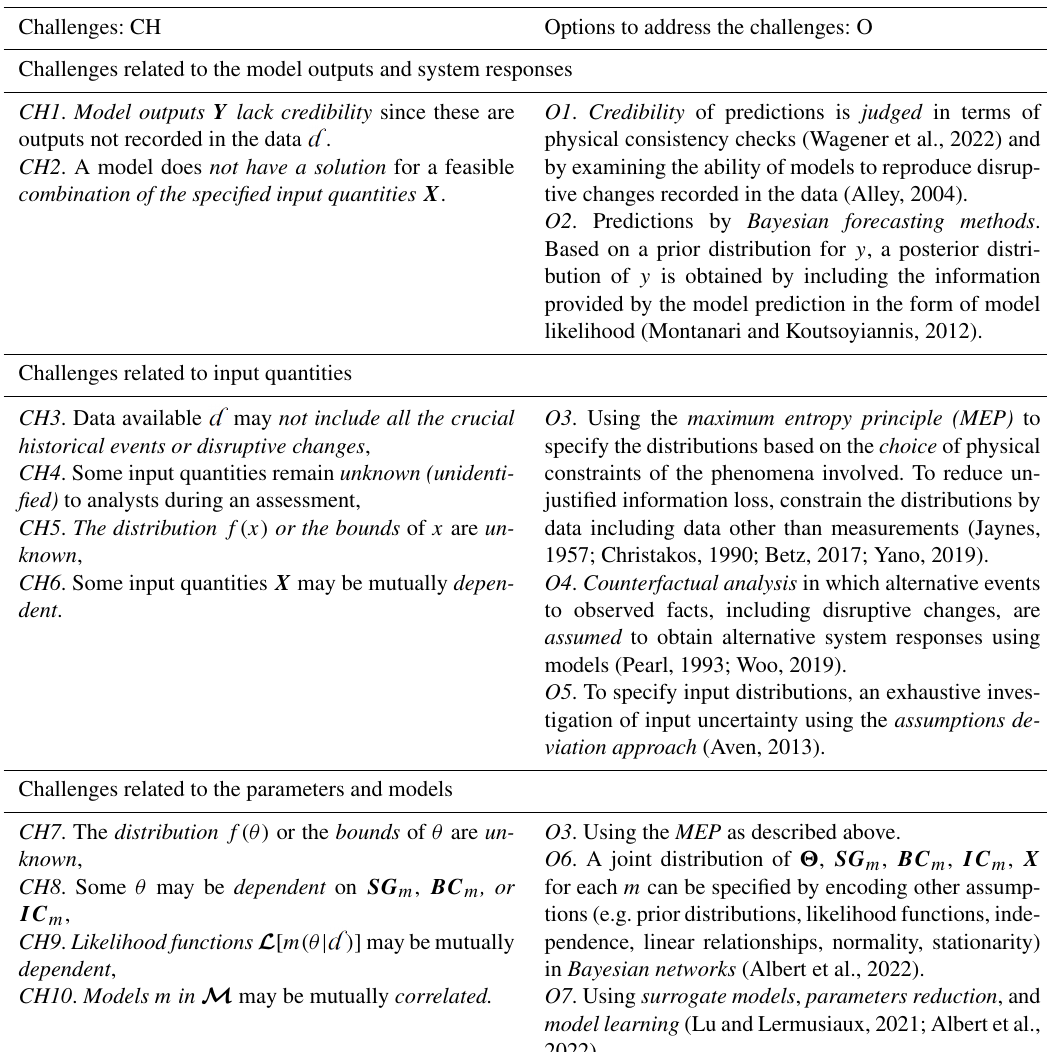
Table 2. Major challenges and options to address them in geohazard